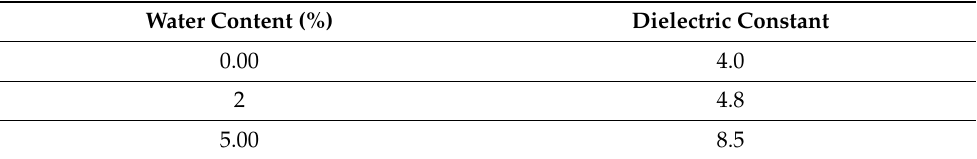
Table 6. Dielectric constants at different moister